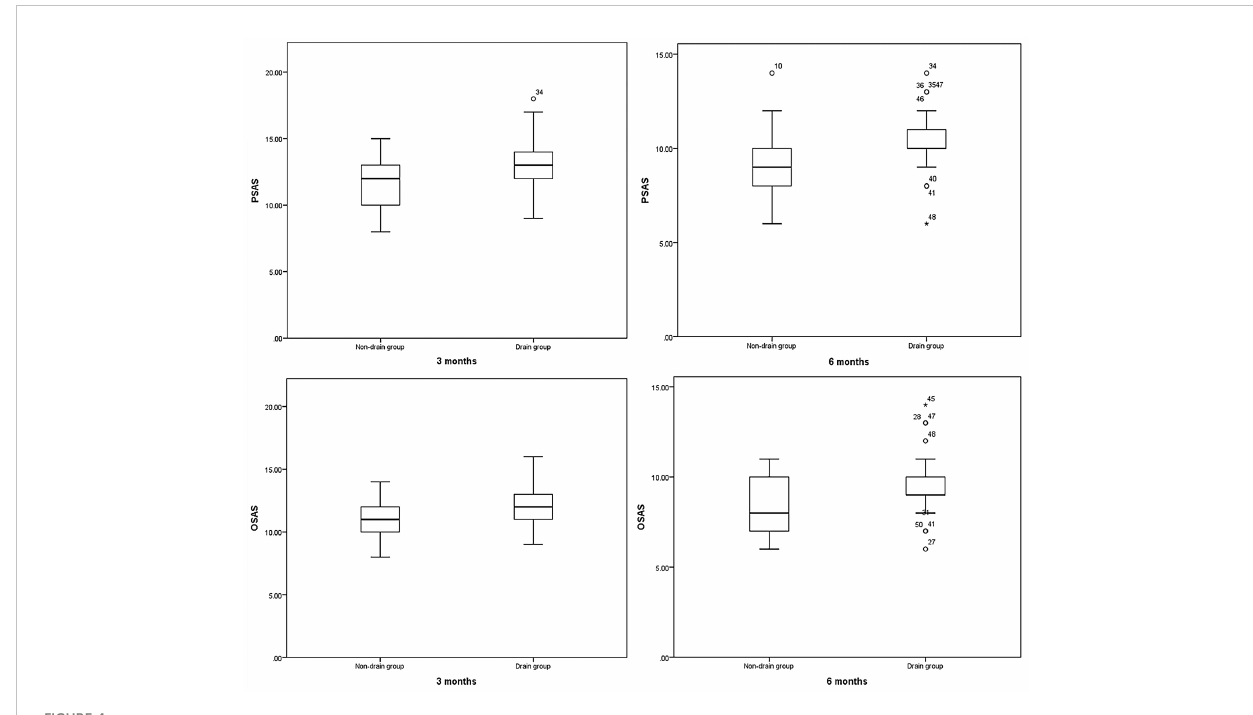
FIGURE 4 Comparison of POSAS between Non-drain group and Drain group. Both